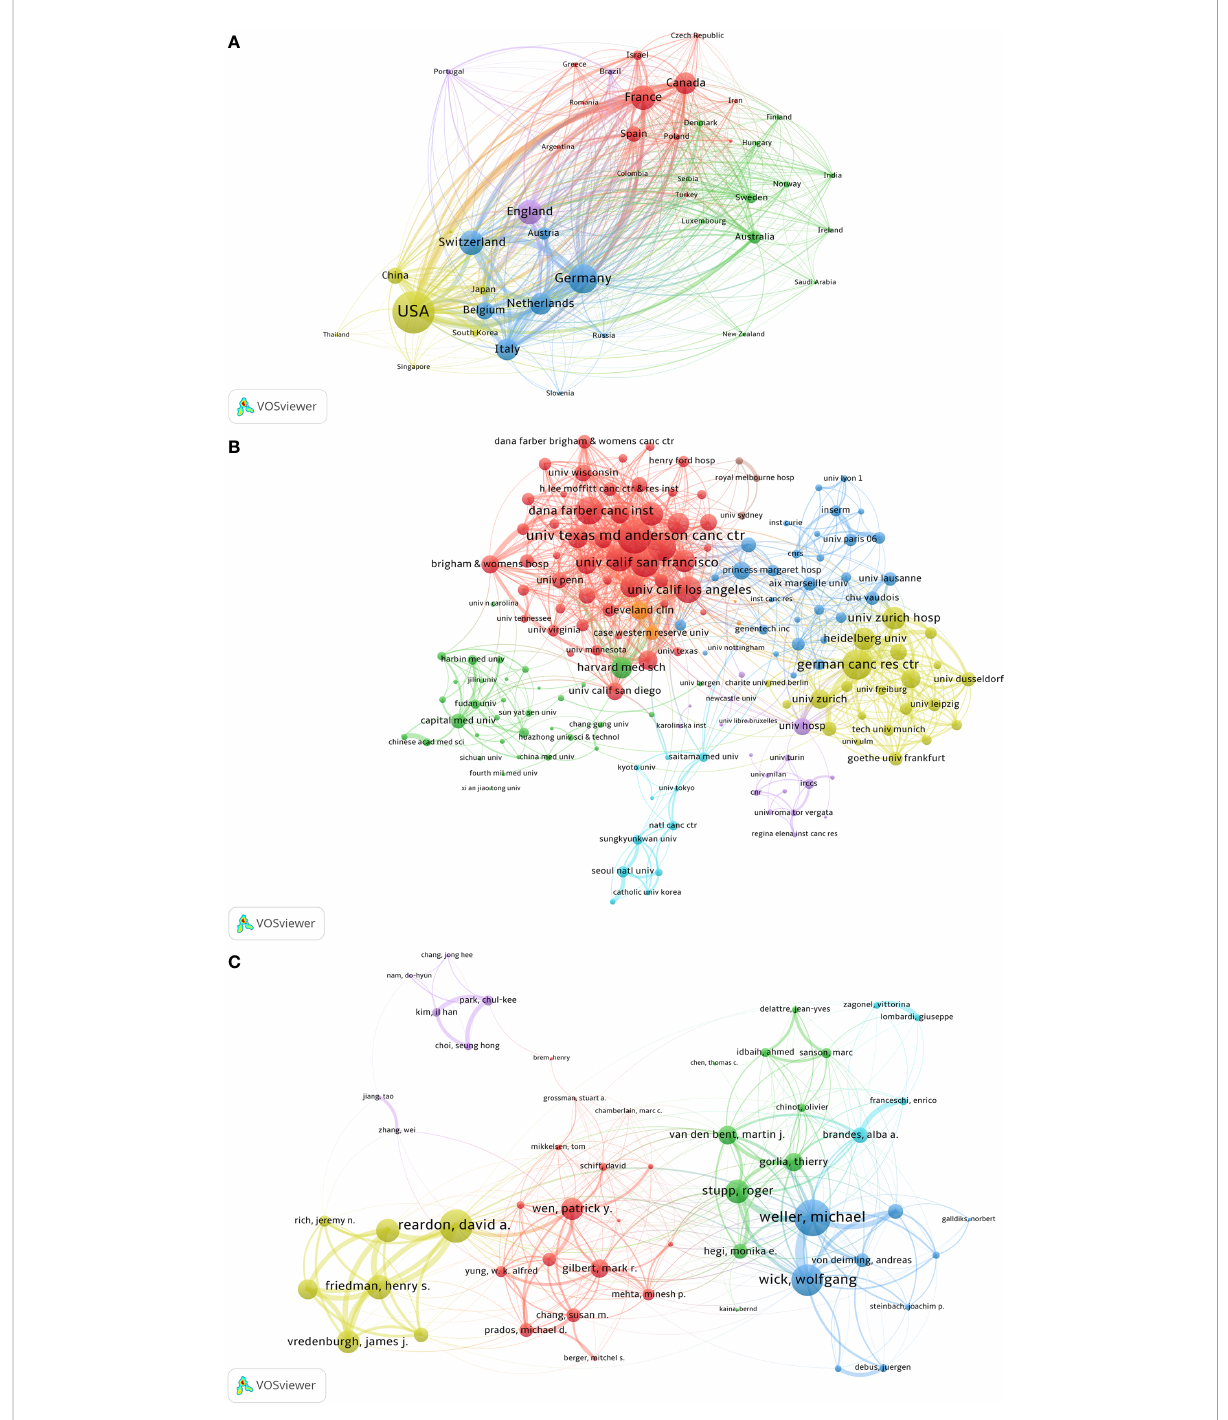
FIGURE 5 Academic collaboration between countries, institutions, and authors in the TMZ research area. (A) Academic collaboration between different countries. (B) Collaboration between different institutions. (C) Collaboration between different authors. From: CiteSpace, VOSviewer